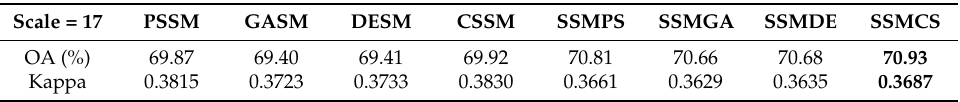
Table 6. Comparison of the land-cover change detection performances of the sub-pixel mapping algorithms in Experiment 3 (change/no